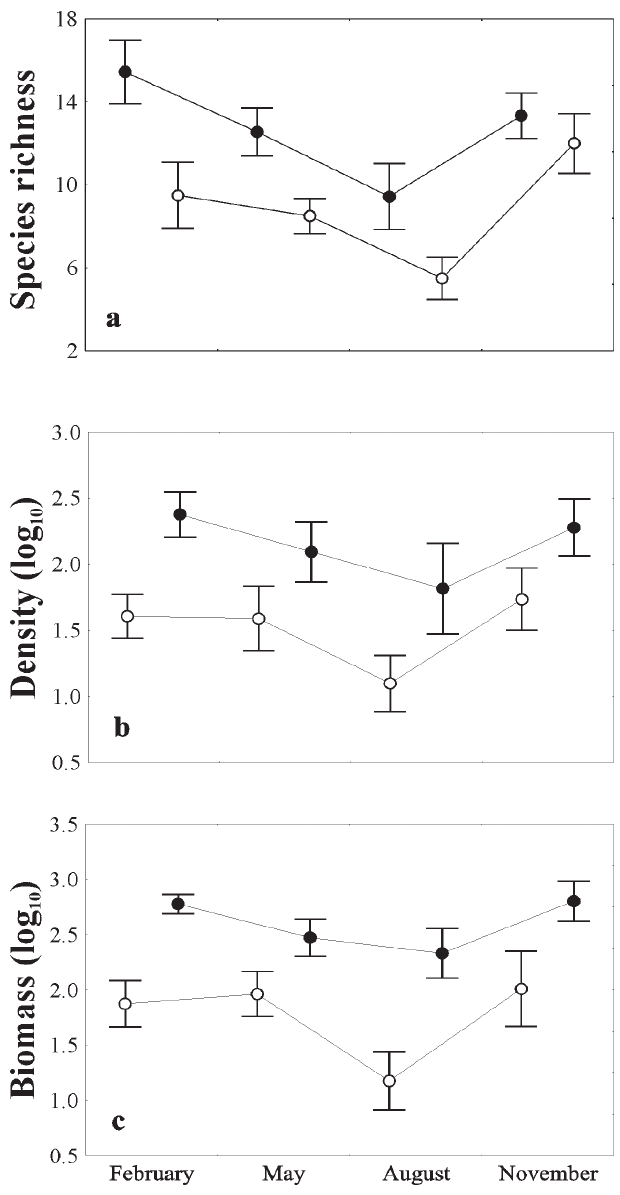
Fig. 3. Average values (± standard error) of species richness (a), density (b), and biomass (c) in connected ( ) and disconnected ( ) lagoons.